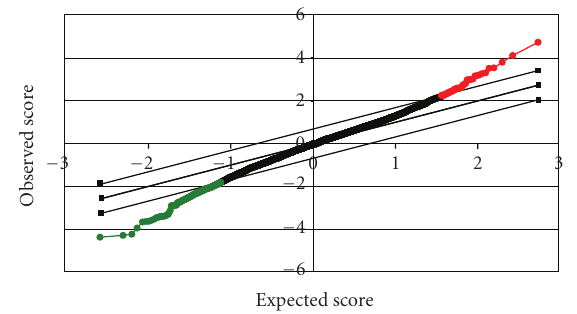
Figure 1: The SAM plot where the significant genes are distributed at the two ends. Significant: 242, Median number of false positives: 11.31, False Discovery Rate (%): 4.67, Tail strength (%): 36.2, and se (%):